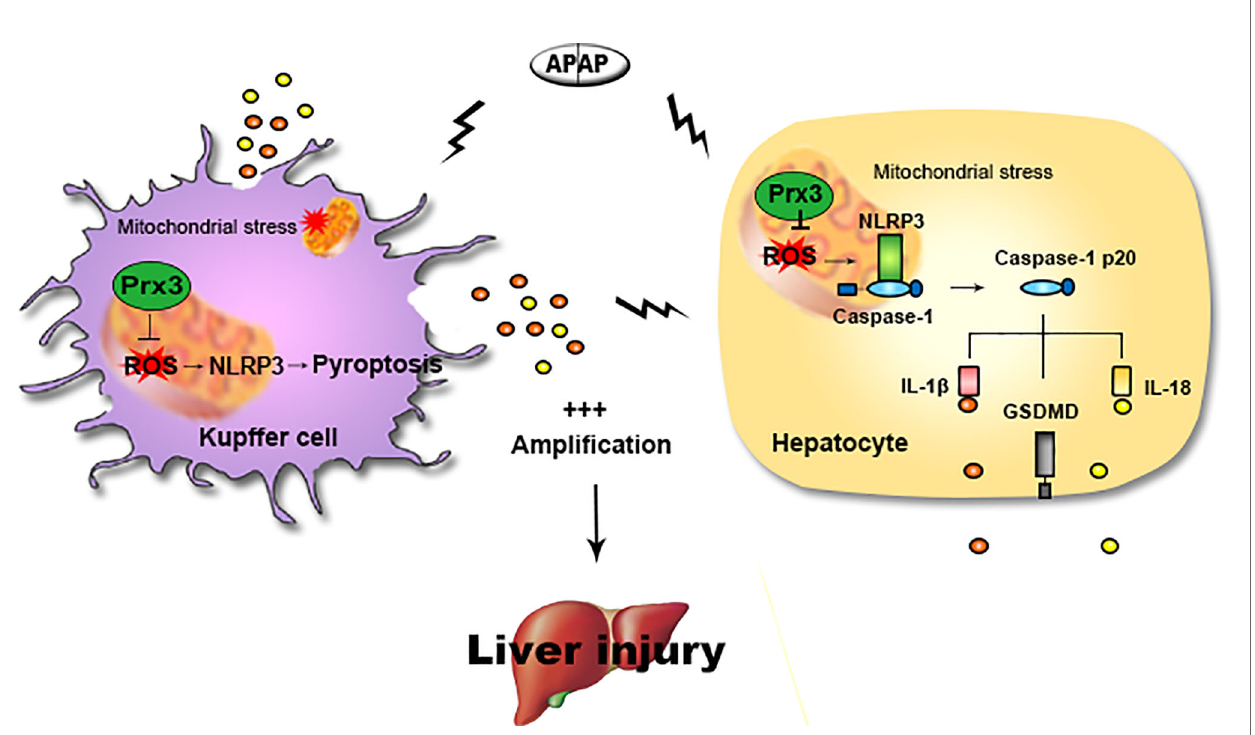
FIGURE 6 | Illustration of the mechanism by which PRX3 alleviates APAP-induced pyroptosis. Excessive APAP promotes NLRP3-mediated pyroptosis in mice. The crosstalk between KCs and hepatocytes ampli fi es the pyroptotic signal. PRX3 overexpression alleviates the above process by disrupting NLRP3 in fl ammasome activation. Moreover, PRX3 regulates NLRP3 in fl ammasome activation by targeting mitochondrial